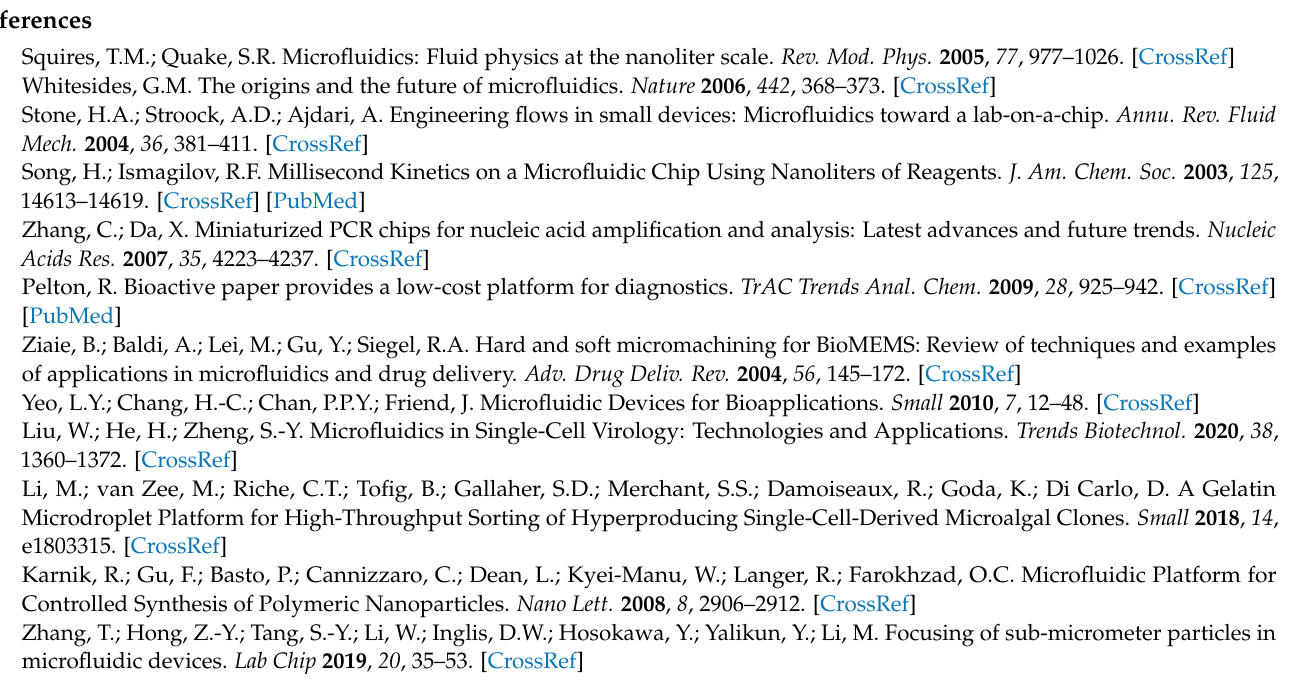
of polystyrene particles having different sizes:10- µ m (2.5 ± 26.7 µ m), 4.5- µ m (0.4 ± 41.9 µ m) and 0.75- µ m ( − 0.2 ± 59.9 µ m) in a microchannel with fs laser engraved 60 ◦ grooves. The injection flow rate is 500 nL/min. Particle lateral positions were detected at the end of block 3 (outlet). 200 particles are measured for each group; Figure S5: Particle distributions at different height levels at the end of block 3 (outlet). (a) Distributions of 15-, 10- and 4.5- µ m polystyrene particles in the channels without groove microstructures. The focal position is 15 µ m above channel bottom. The injection flow rate is 1000 nL/min. (b) Distributions of different sized polystyrene particles at different height levels: bottom (upper pictures) and 15 µ m above channel bottom base (lower pictures), when the injection flow rate is 500 nL/min. (i,ii) Distributions of (i) 10- and (ii) 4.5- µ m polystyrene particles in the channel with groove structures. (iii–v) Distributions of (iii) 15-, (iv) 10- and (v) 4.5- µ m in the channels without groove structures. Bottom base refers to the position where a particle is in focus under a static condition. 15- and 10- µ m particles are observed under a 40 × objective lens and 4.5- µ m particles are observed under a 60 × objective lens. Scale bar is 60 µ m; Figure S6: Particle sedimentation in 10-mL tubes at different time points. Particle concentrations are 5 × 105, 1.7 × 107, 1.1 × 109 particles/mL for 10.0-, 3.0- and 0.75- µ m fluorescent particle solutions, respectively. Video S1: 4.5- µ m particles flowing at 1000 nL/min; Video S2: 0.75- µ m particles flowing at 1000 nL/min; Video S3: 0.75- µ m particles flowing at 500 nL/min; Video S4: selective focusing of 10- µ m